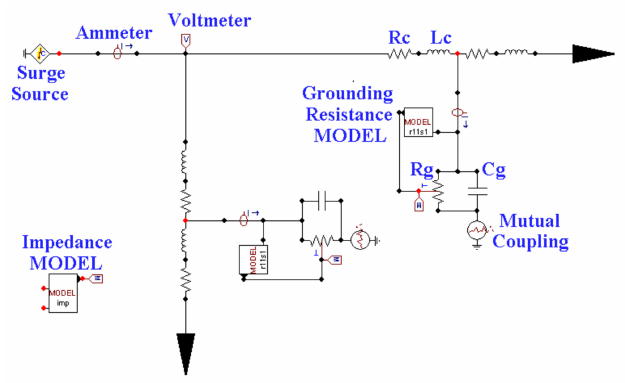
Figure 9. Example of ATP model for mesh simulations.